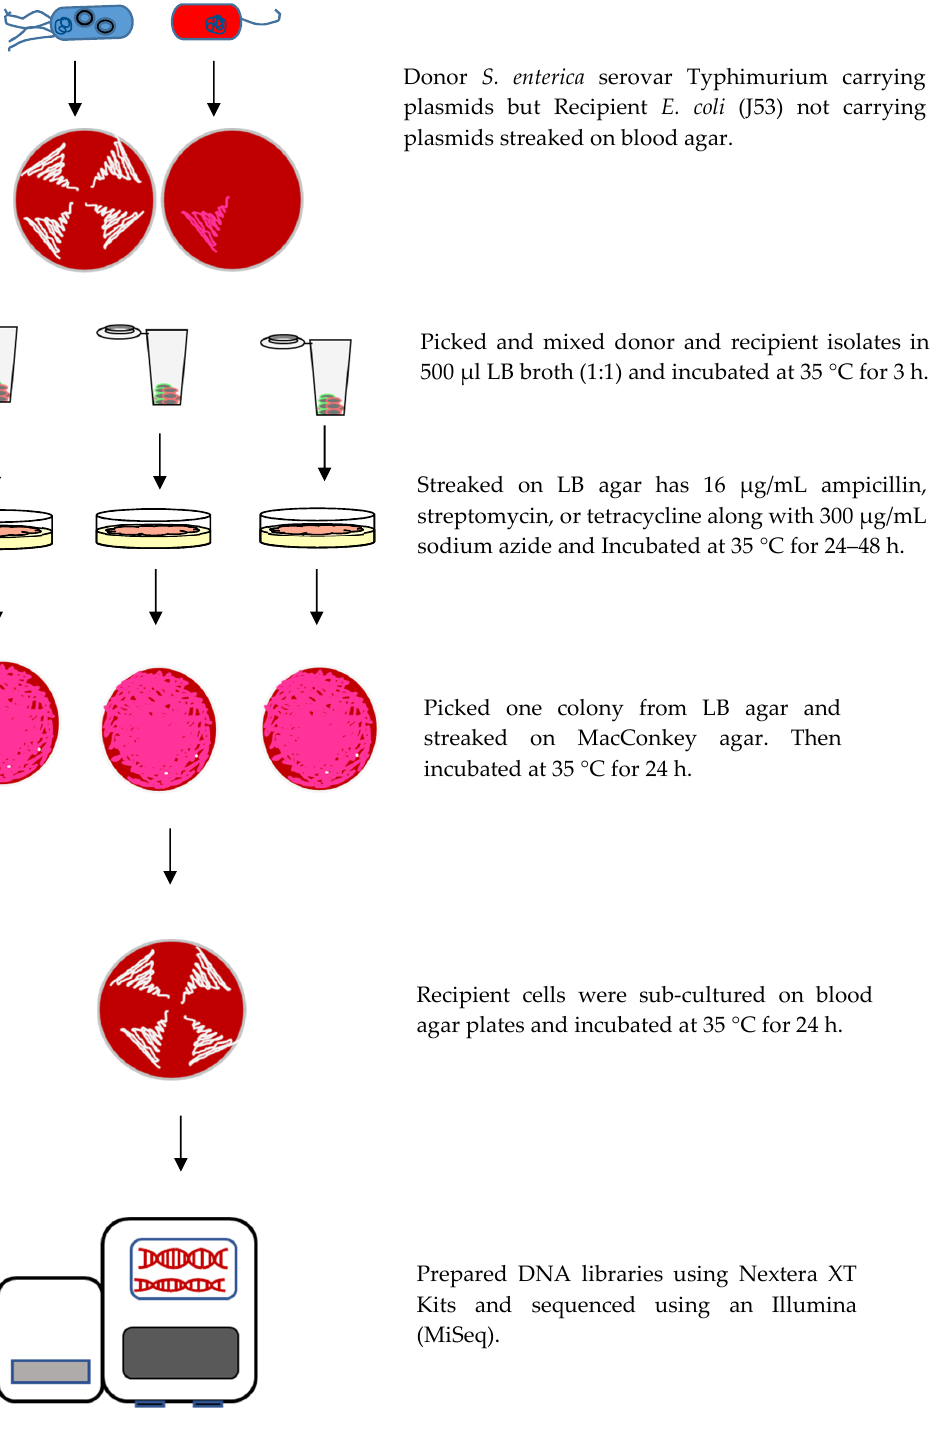
Figure 1. Schematic of conjugation process of Donor S . Typhimurium and E. coli J53.